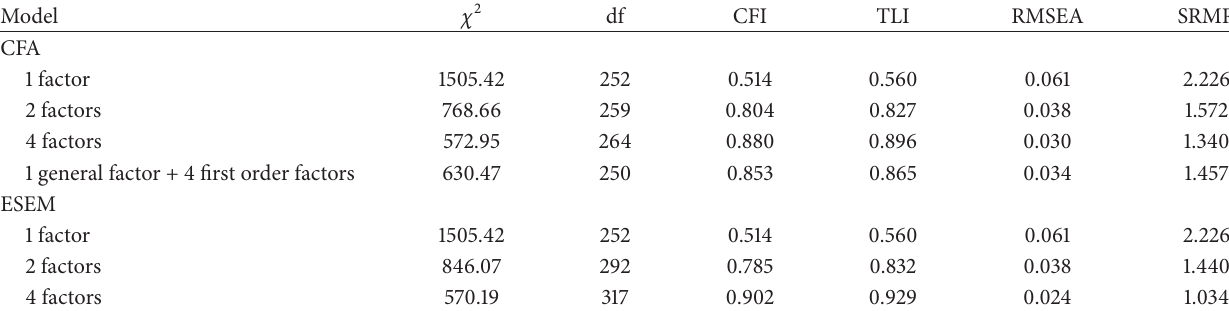
Table 2: Goodness-of-fit indices of hypothetical models